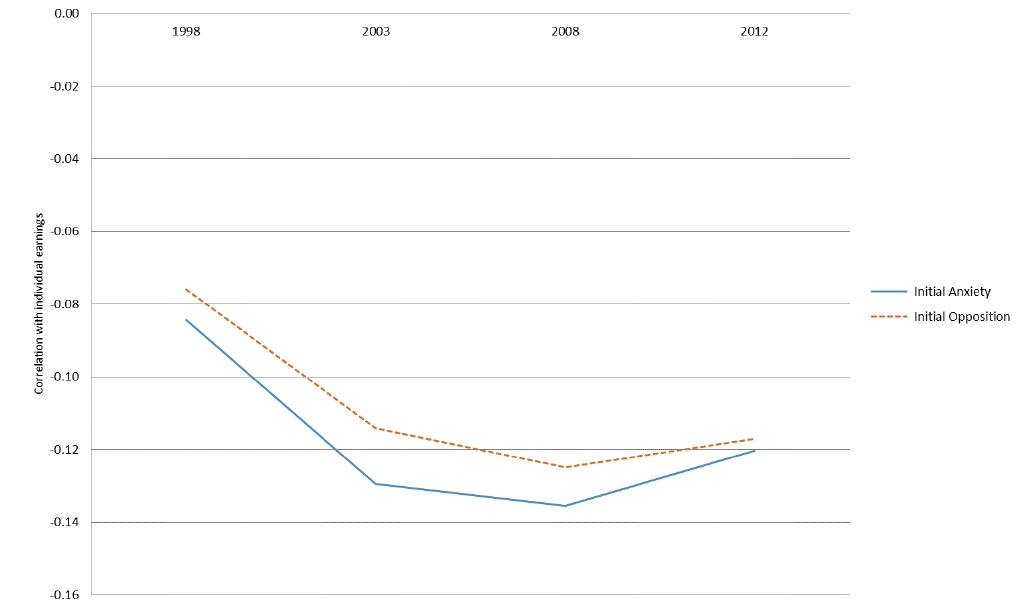
Figure 1: Individual earnings and childhood behavior